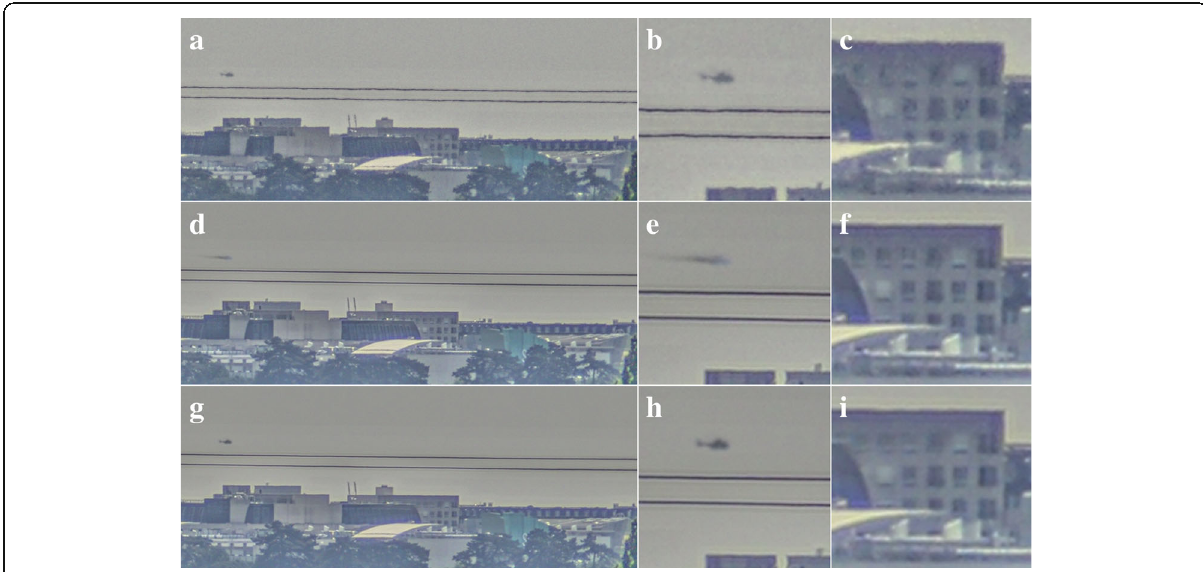
Fig. 4 Turbulence mitigation on a helicopter flying over a city. The helicopter is about 55 × 25 pixels in size. The top row shows a still from the raw video ( a ) and cut-outs around the helicopter ( b ) and a building ( c ). The middle row ( d - f ) shows the processing results with the global turbulence mitigation method and the bottom row ( g - i ) shows the result for dynamic turbulence mitigation with Lucas-Kanade optical